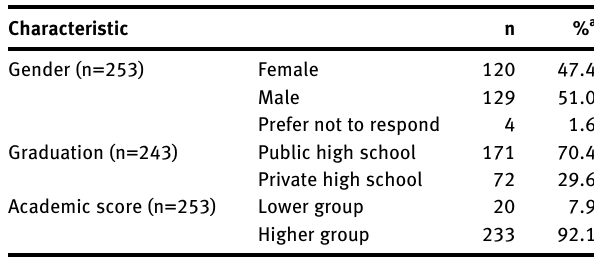
Table  : Characteristics of the student cohort.